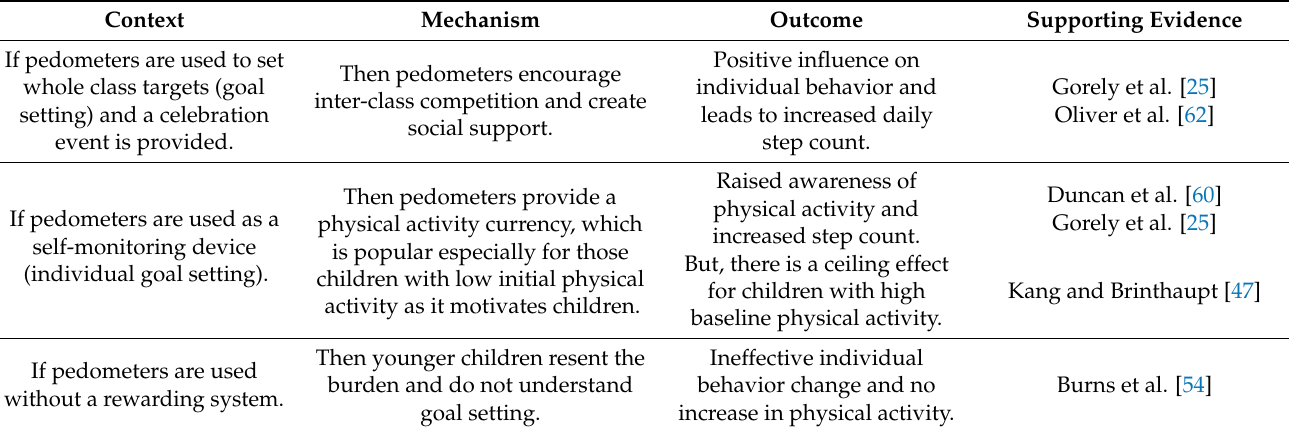
Table 1. Individual level (child) of a conceptual framework for school-based physical activity interventions in children aged 7–11 years of program theories (context-mechanism-outcome).